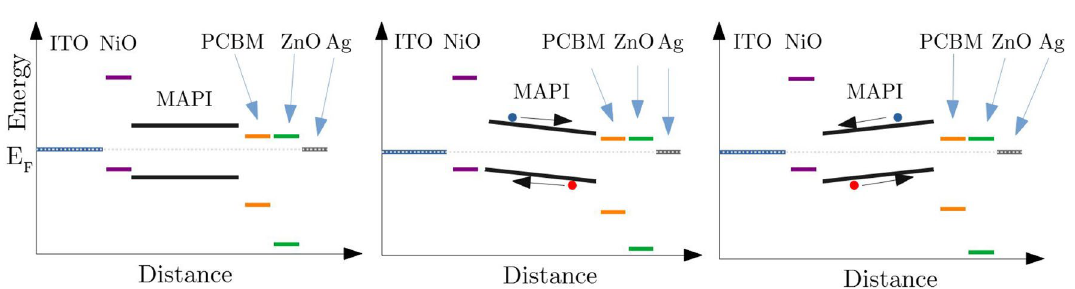
Figure 8. Schematic illustration of the band diagrams resulting from doping gradients within the MAPI absorber. Here, the blue circle illustrates the electrons and the red circle the holes. The left image shows the solar cell with a fully converted MAPI absorber without stoichiometry variations/gradients (Eva 1). The middle image shows a MAPI absorber with MAI-rich stoichiometry at the NiO interface and PbI 2 -rich stoichiometry at the ETL interface (Eva 4). The right image shows a MAPI absorber whose stoichiometry is PbI 2 -rich at the NiO interface and MAI rich on top of the absorber (Eva